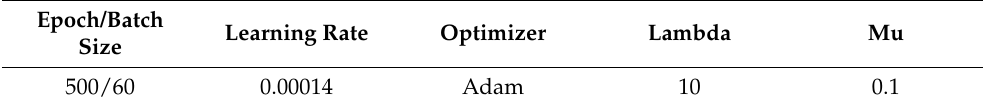
Table 7. Training parameter settings of CycleGAN generating system.